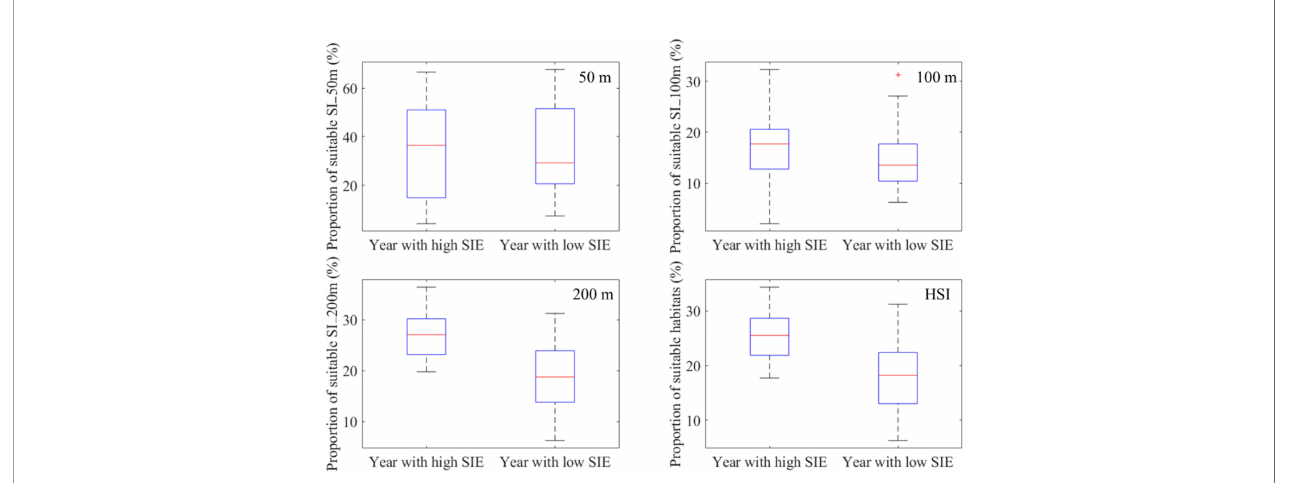
FIGURE 6 | Comparison of the proportion of suitable suitability index for sea water temperature at depths of 50 m (SI_50m ≥ 0.6), 100 m (SI_100m ≥ 0.6), and 200 m (SI_200m ≥ 0.6) and the proportion of suitable habitat (areas with HSI ≥ 0.6) between the year groups with high and low sea ice extent